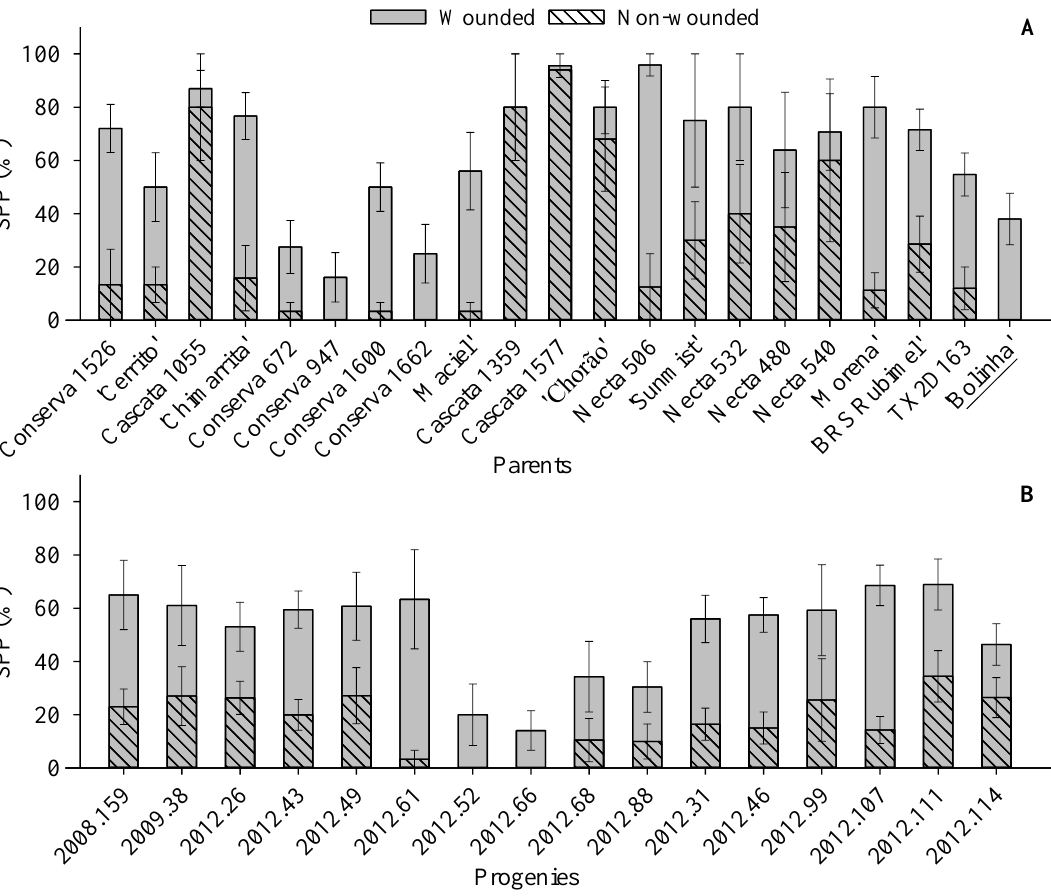
Figure 3. Sporulation presence (SPP) on wounded and non-wounded fruits of parents ( A ) and progeny ( B ) averages for three and two seasons (2015 – 2016; 2016 – 2017; 2017 – 2018 and 2016 – 2017; 2017 – 2018, respectively). ‘ Bolinha ’ was included as control. Embrapa Peach Breeding Program, Pelotas, Rio Grande do Sul, Brazil.